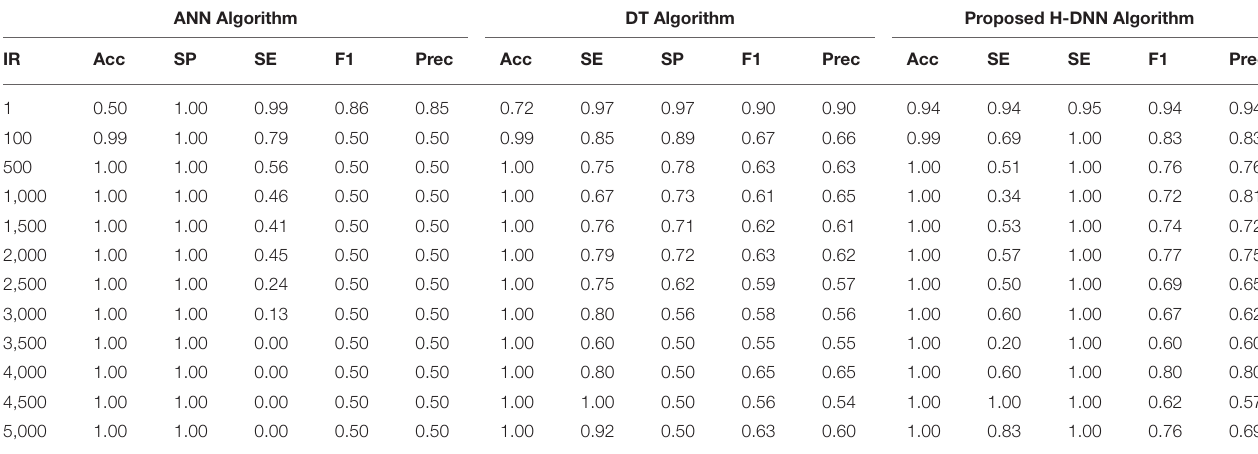
TABLE 6 | ANN and DT results using human